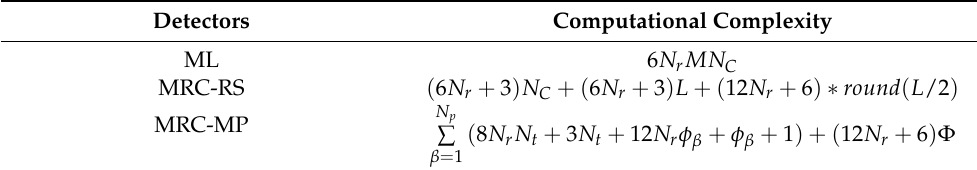
Table 3. Comparison of above-mentioned detectors for M-QAM constellation.